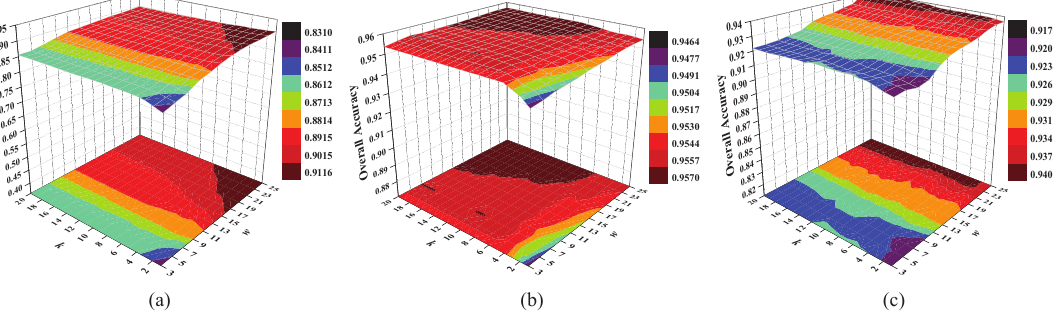
Figure 5. Overall classification accuracies (OAs) with different window sizes w and neighbor number k . ( a ) PaviaU. ( b ) Heihe. ( c ) Washington DC